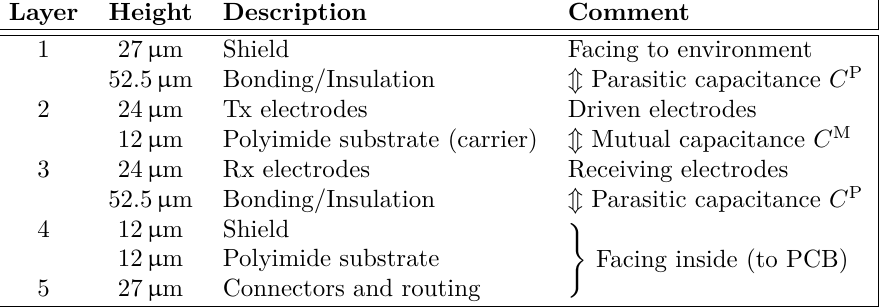
Table 1: Layer stack-up of the flexPCB cover with overall thickness of 243 µ